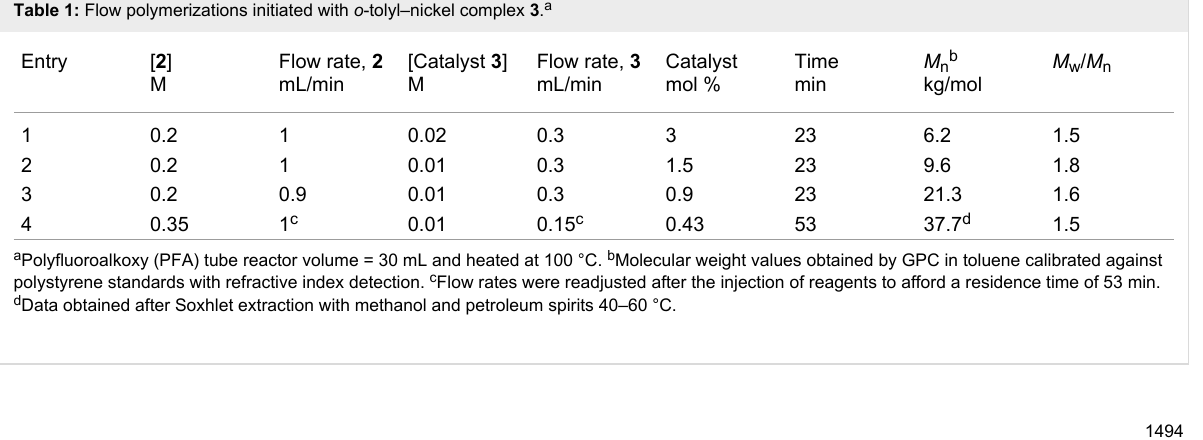
Table 1: Flow polymerizations initiated with o -tolyl–nickel complex 3 .